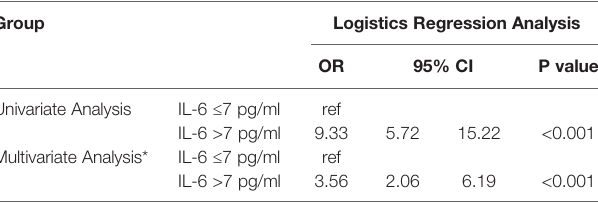
TABLE 5 | The risk of elevated IL-6 for disease severity of COVID-19. Group